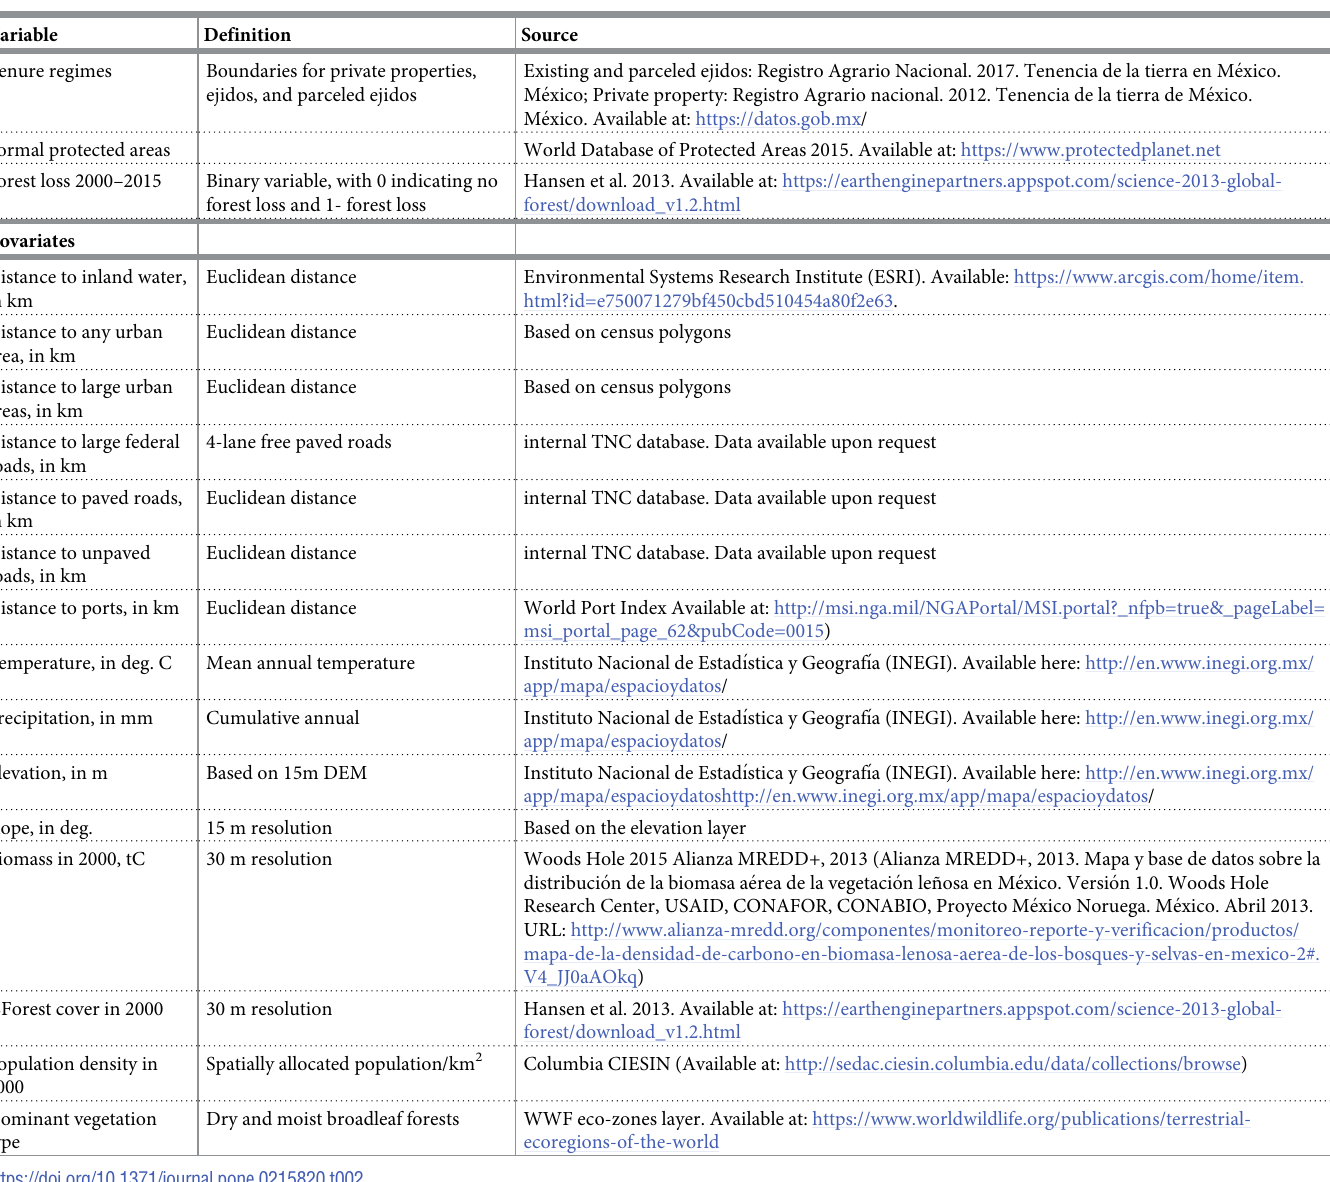
Table 2. Data sources and variable